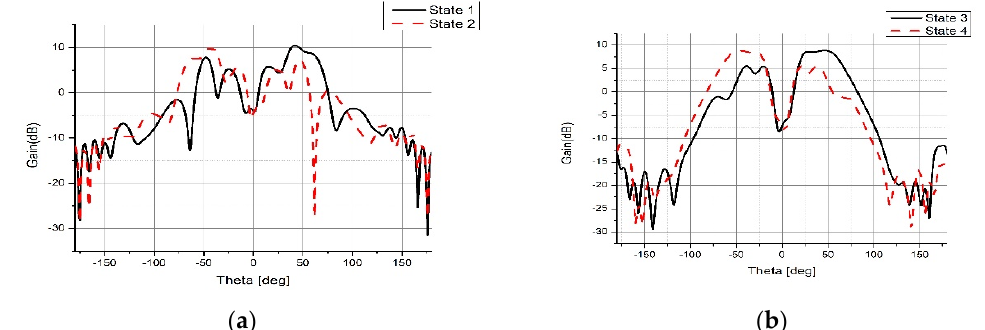
Figure 11. The radiation patterns result at 5.5 GHz ( a ) φ = 90° ( b ) φ = 0°.